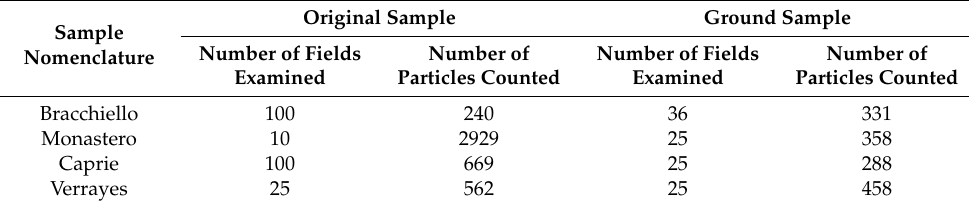
Table 3. Number of fields examined and particles counted for each